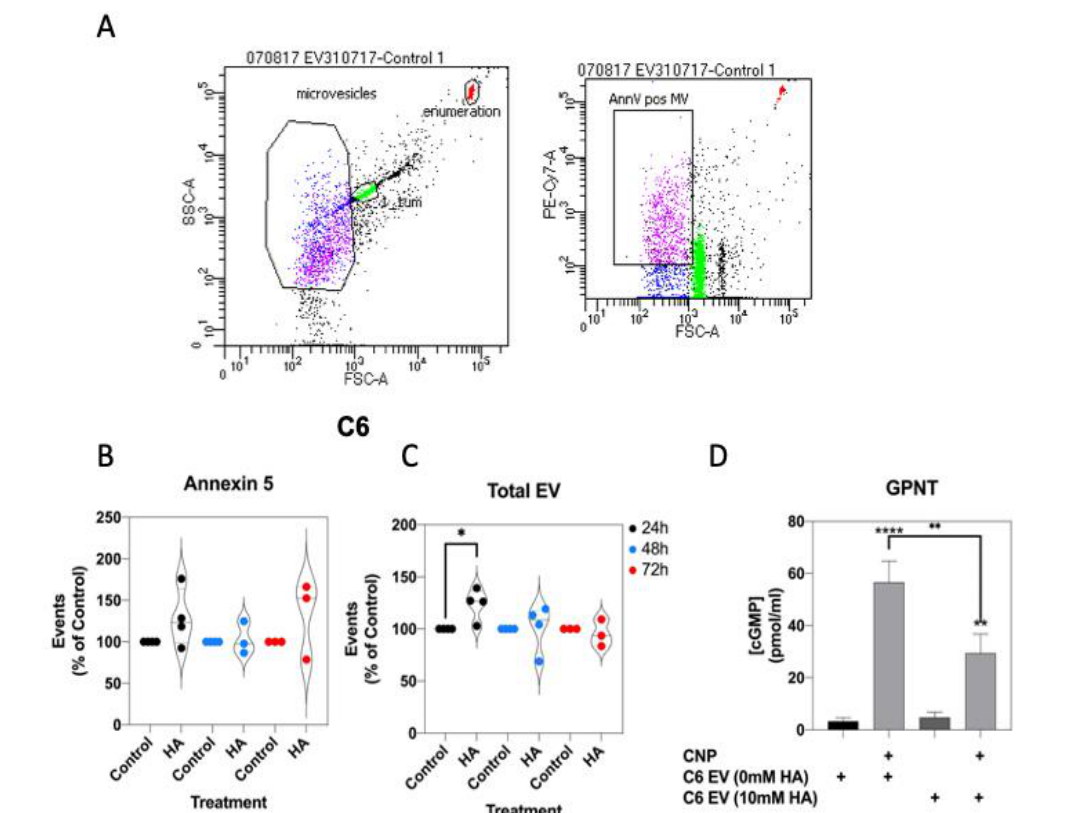
Figure 9. Effects of hyperammonaemia on extracellular vesicle production from C6 cells, and their functional effects on GPNT cells. ( A ) Extracellular vesicles were harvested from spent media from C6 cells treated with 0 or 10 mM NH 4 Cl for up to 72 h. These vesicles were stained with Cy7-labelled Annexin-5 and analysed by FACS. Data shown are representative FACS dot plots, showing gating parameters. ( B , C ) Comparison of Annexin-5-positive extracellular vesicles, and total extracellular vesicles from C6 cells treated with 0 or 10 mM NH 4 Cl. Data shown are medians (with 5 to 95% confidence intervals) of events, normalized to % of control treated cells, from 3 to 4 independent experiments. * p < 0.05, significantly different from control). ( D ) Effects of C6-derived extracellular vesicles on CNP-stimulated cGMP accumulation in GPNT cells. GPNT cells were treated with extracellular vesicles from control or NH 4 Cl-treated C6 cells, for 24 h, prior to subsequent stimulation with 100 nM CNP in the presence of 1 mM IBMX for 1 h. The data shown are means ± SEM from 6 to 9 independent stimulations. **** p < 0.0001, ** p < 0.01 significantly different from unstimulated; * p < 0.05, significantly different from CNP response in C6 EV (0 mM HA)